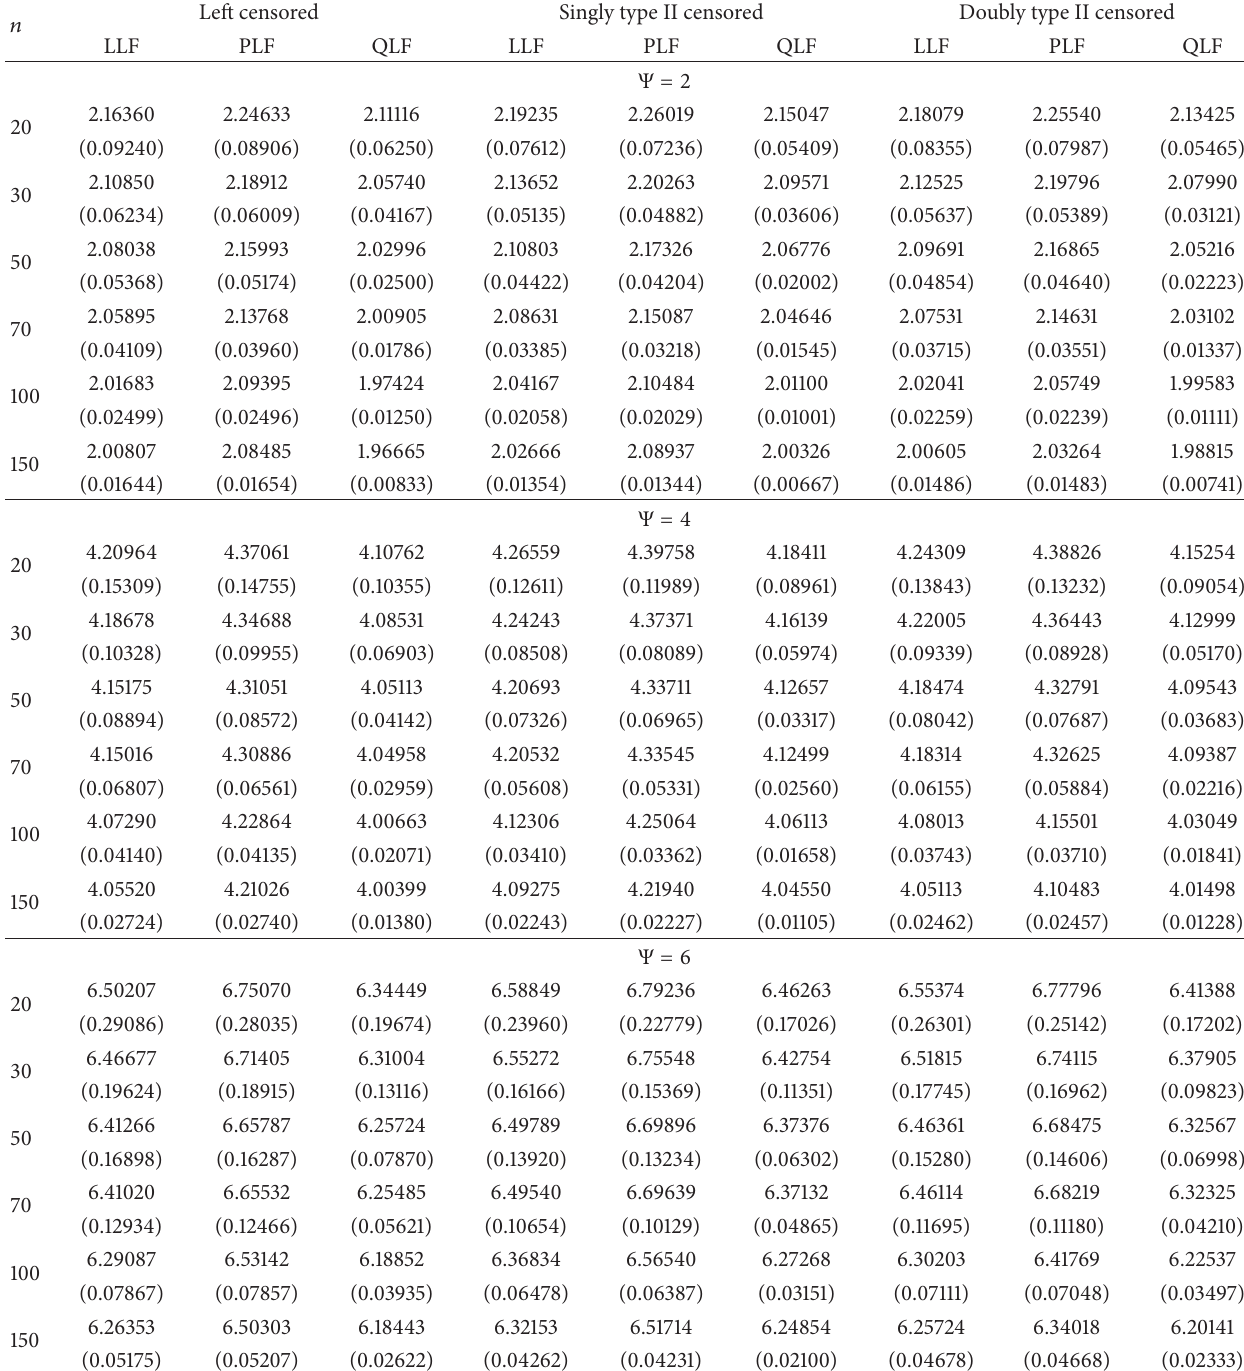
Table 1: Bayes estimators and posterior risks under uniform